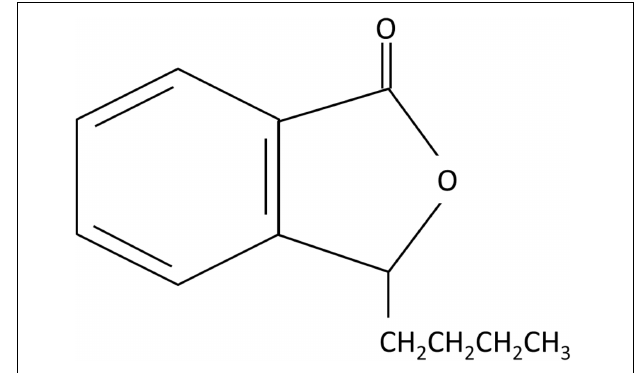
FIGURE 1 | Chemical structure of DL-3- n -butylphthalide